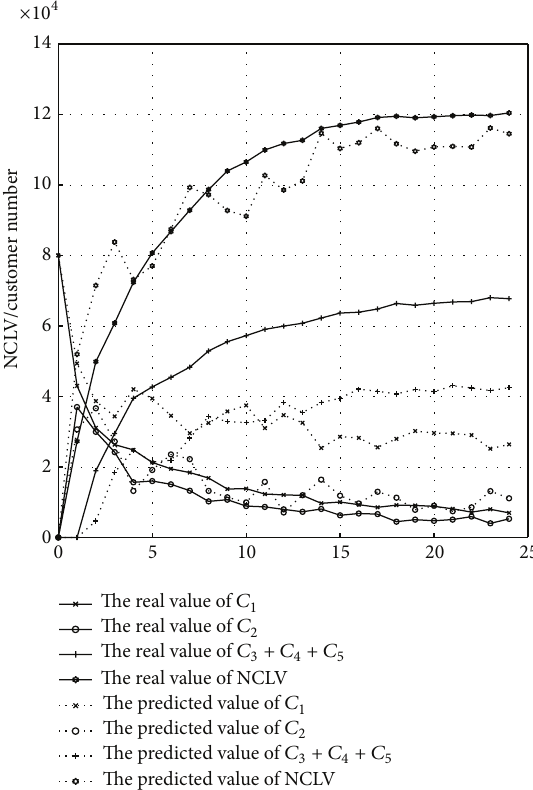
Figure 11: The comparison results for the test case with maximum similarity.